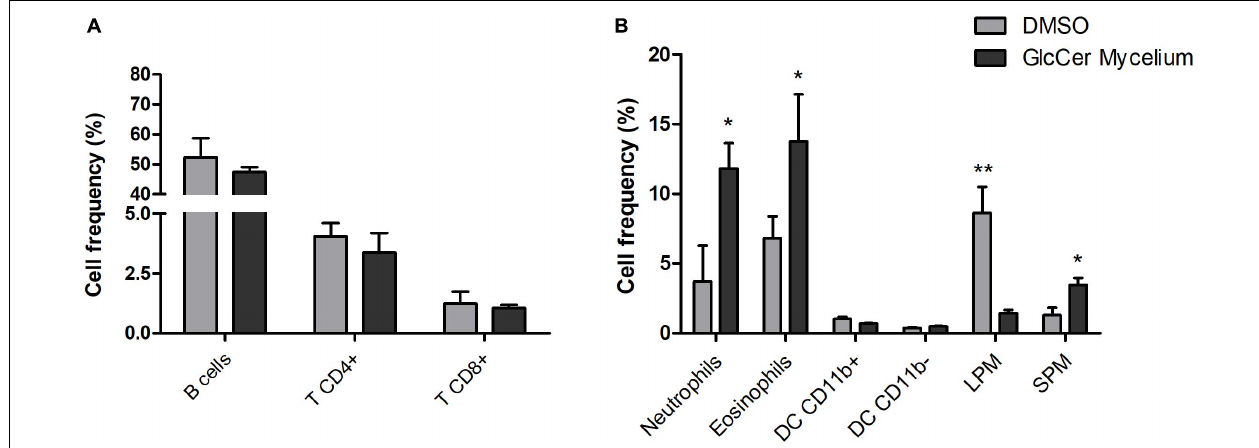
FIGURE 9 | GlcCer species from L. prolificans mycelium induce recruitment of neutrophils, eosinophils and small peritoneal macrophage (SPM) in the peritoneal cavity 24 h after the injection. Mice were treated intraperitoneally with 0.5% DMSO in PBS (DMSO) or 200 µ g GlcCer species from mycelium, and after 24 h lymphoid (A) and myeloid cells (B) in the peritoneal cavity were evaluated by flow cytometry. DC, dendritic cell; LPM, large peritoneal macrophage; SPM, small peritoneal macrophage. The results were analyzed with paired t -test with ∗ p ≤ 0.02 or ∗∗ p ≤